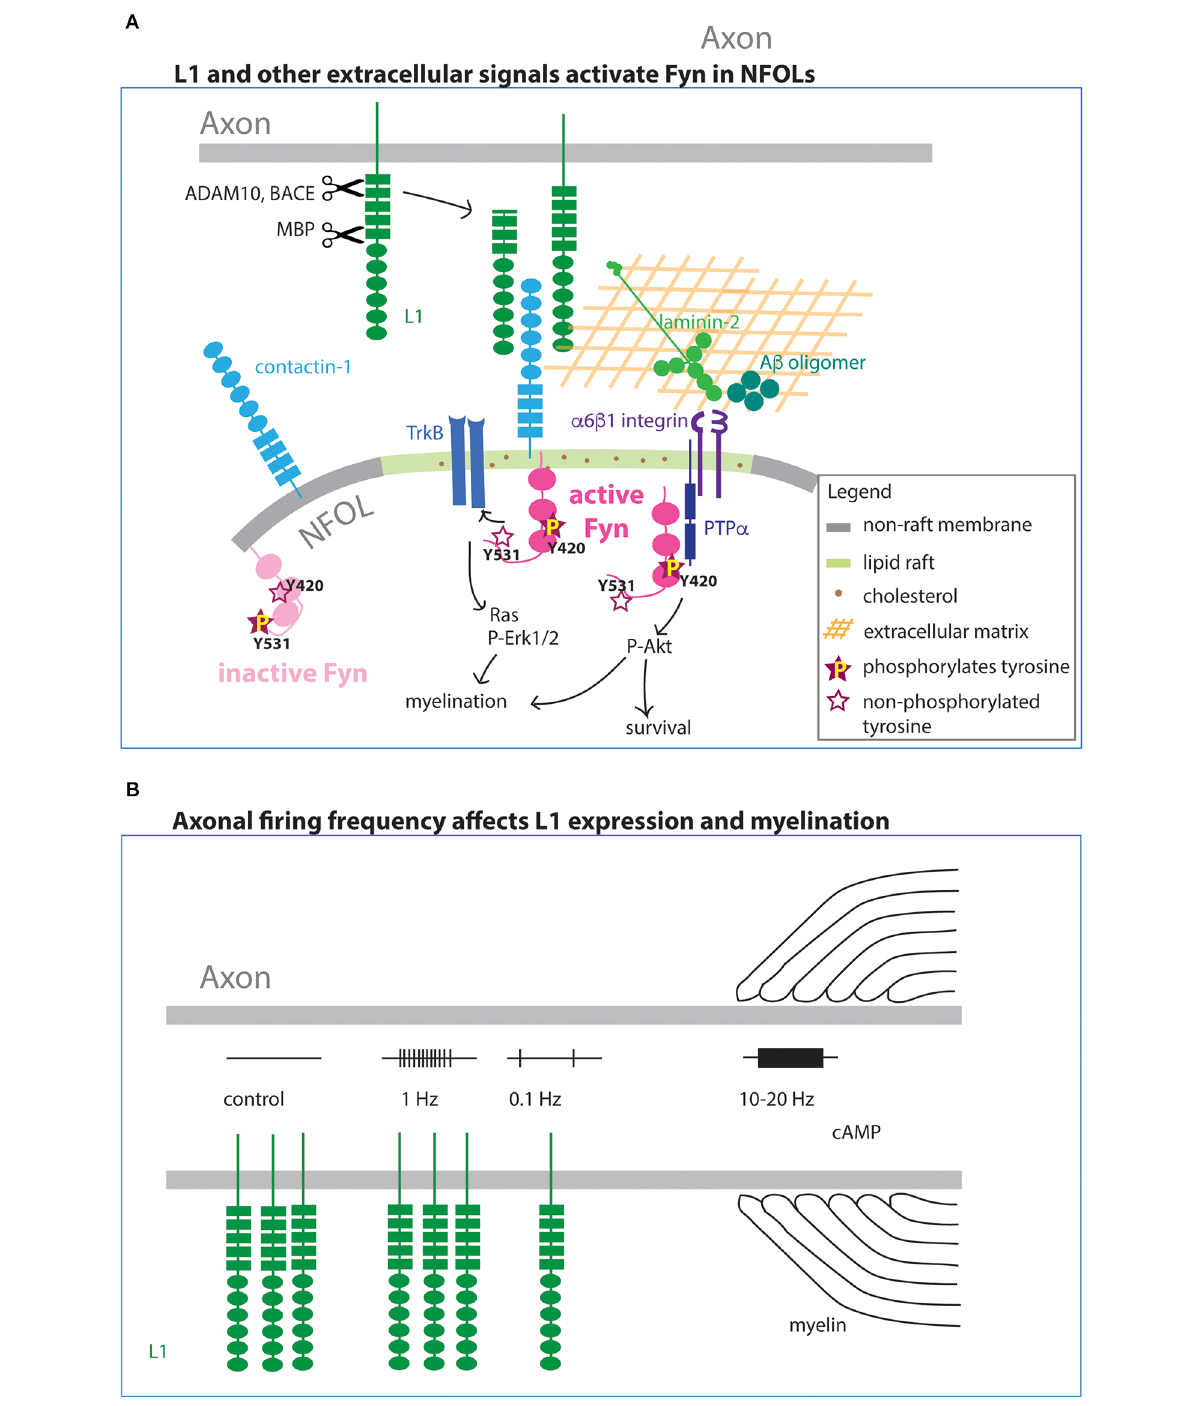
FIGURE4 Integral membrane and extracellular matrix affecting myelination via Fyn (A) . Axonal L1 forms a complex with contactin-1 on OLs. The complex becomes preferentially localized to lipid rafts, where they complex with and activate Fyn by phosphorylated Y420. Fyn in the non-raft membrane is not active (not phosphorylated on Y420 but phosphorylated on the regulatory Y531 site). In addition to the membrane-bound form, cleaved L1 also interacts with contactin-1. In addition to L1, the extracellular molecules laminin-2 and A β oligomer also activate Fyn on OLs. Activated Fyn also promotes TrkB function. (B) The level of L1 expression on the surface of the axon is regulated by the frequency of action potential firing. High-frequency firing increases myelination, and this effect in some cases is mediated by